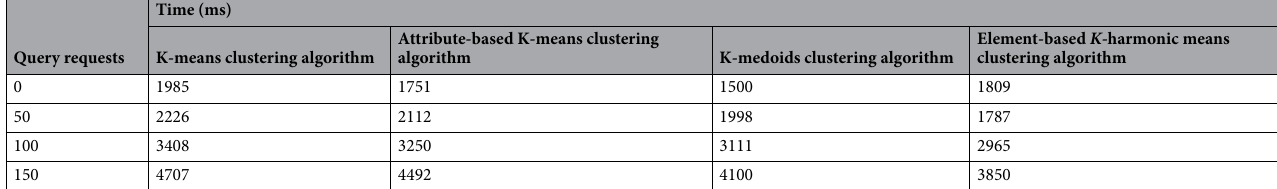
Table 1. Computation of time for M =